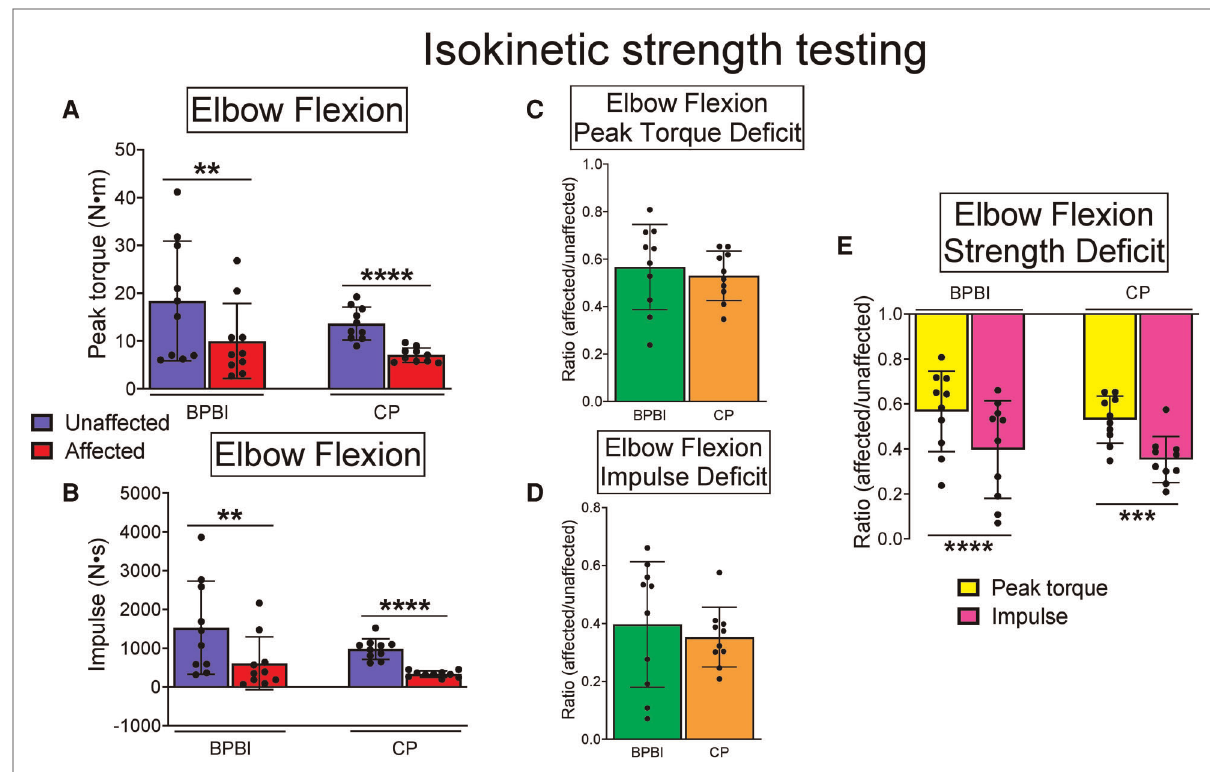
FIGURE 3 Isokinetic elbow fl exion strength testing in BPBI and CP subjects, with 60 m/s and 120 m/s data pooled. ( A ) Peak torque was lower on affected versus unaffected sides for both BPBI and CP subjects. ( B ) Impulse, or area under the torque-angle curve, also known as total work, was reduced on the affected versus unaffected sides for both BPBI and CP subjects. The de fi cit in peak torque ( C ) and impulse ( D ) did not differ between BPBI and CP subjects. ( E ) The de fi cit in impulse was greater than the de fi cit in peak torque for both BPBI and CP subjects. ** p <0.01, *** p <0.001, **** p <0.0001.